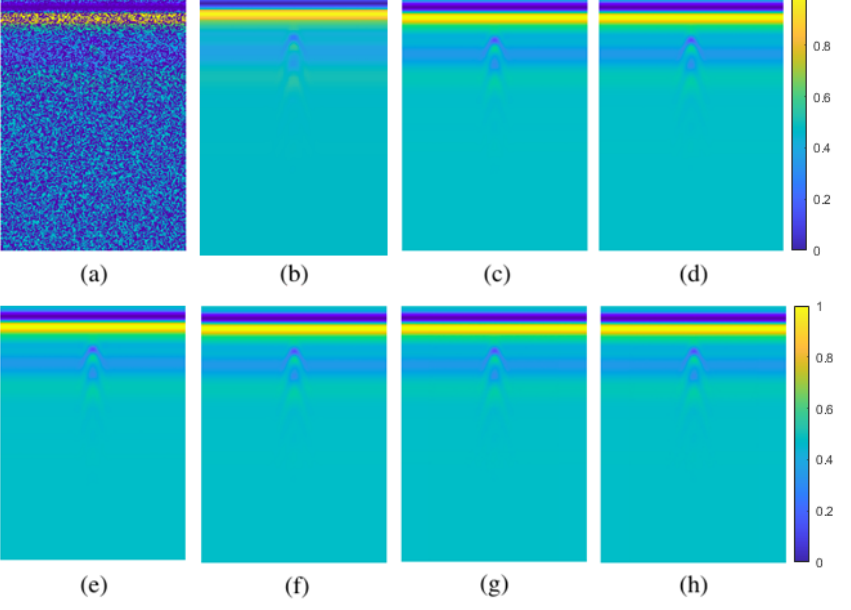
Figure 8. 50% pixel-wise missing data case for simulated data: ( a ) GPR image with missing entries, ( b ) original GPR image, recovered images by ( c ) GoDec, ( d ) NMC, ( e ) Lmafit, ( f ) NNM, ( g ) PEN-Net, ( h )